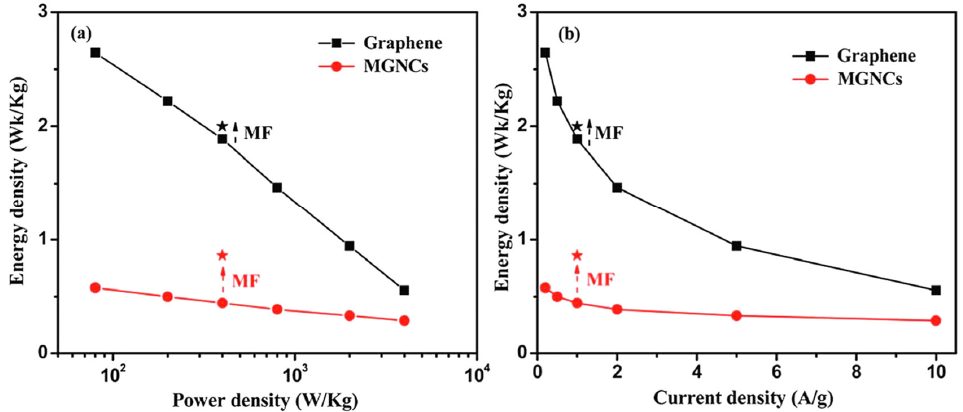
Figure 19. Energy density vs. ( a ) power density and ( b ) current density of graphene and Fe 2 O 3 /graphene composite. Reproduced with permission from [145] Copyright (2012) Royal Society of Chemistry. Table 3. Utilization of external magnetic field for the synthesis and applications.